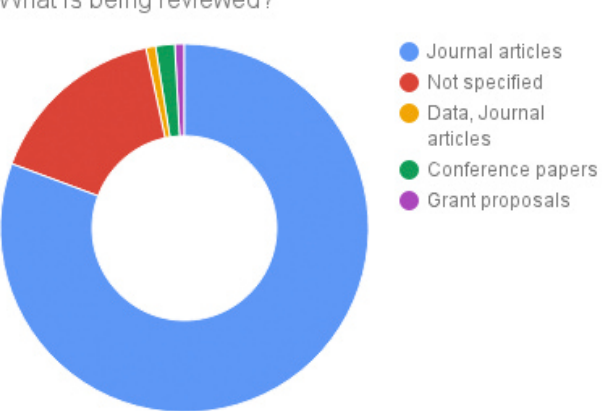
Figure 4. Breakdown of OPR definitions by type of material being